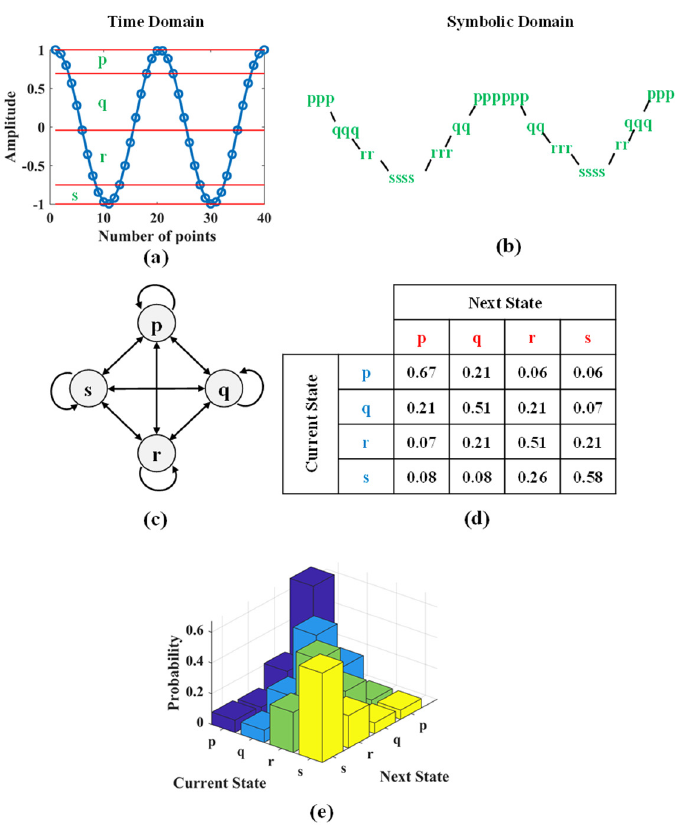
Figure 6. Steps in symbolic time-series analysis. ( a ) a dummy signal (cosine) with 40 points and four partitions; ( b ) the symbolic chain filtered from the signal; ( c ) a state diagram between four states from the partitions; ( d ) the state transition matrix showing the probability of transition between the current state and next state in the signal; ( e ) The state transition matrix in ( d ) is depicted as a 3D plot.